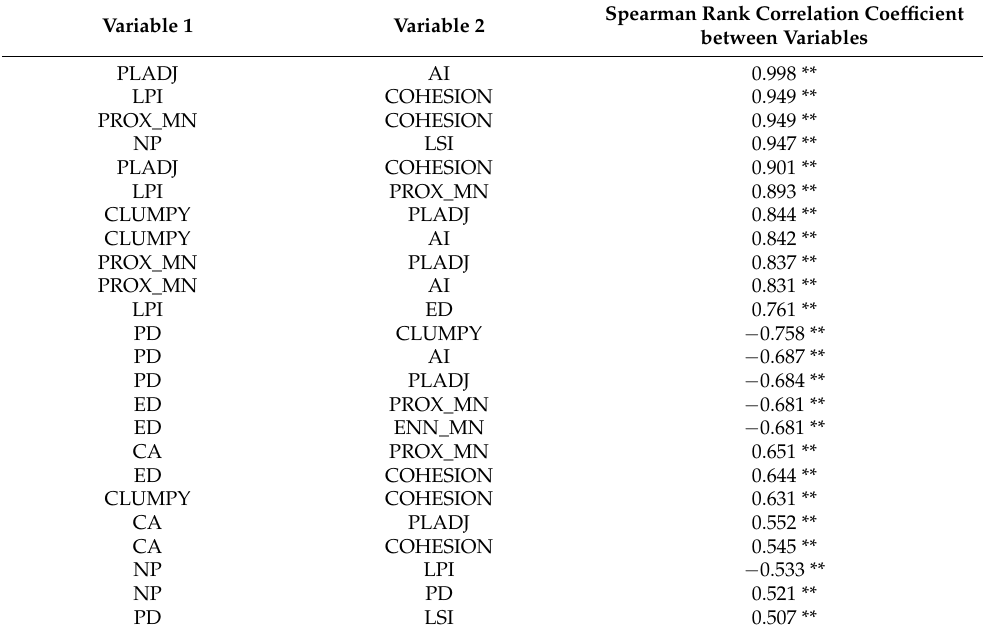
Table 5. Combination table of Gauss Pilman rank correlation